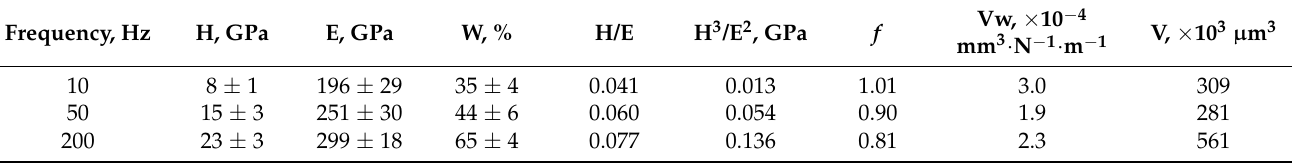
Table 3. Mechanical and tribological properties of the